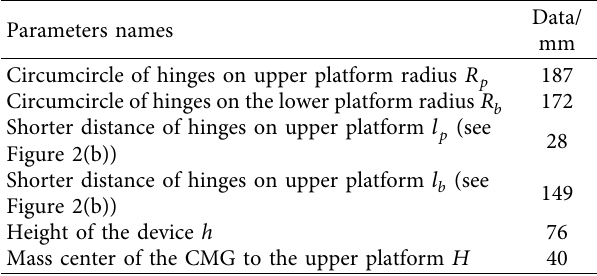
Table 3: Parameters of the vibration suppression device.